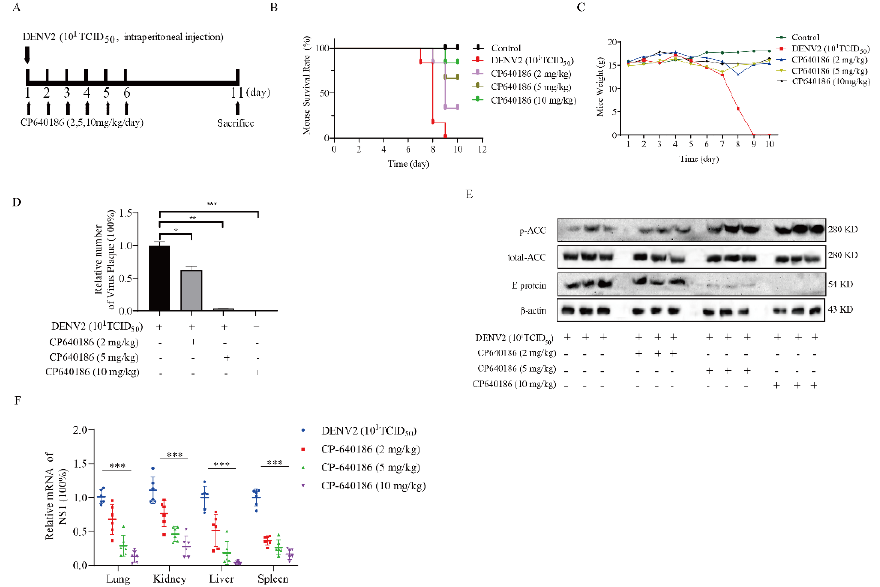
Figure 5. The antiviral effect of CP640186 in vivo. ( A ) Schematic diagram of mice infection assay. IFNAR − / − mice were infected with DNEV2 (10 1 TCID 50 ) at day 1. At the same time, the CP640186 (2 mg/kg/day, 5 mg/kg/day, and 10 mg/kg/day) was administered orally for 6 consecutive days. At day 11, these mice were sacrificed for histological analysis. ( B ) The mice survival rate curve. ( C ) The mice weight curve. ( D ) The inoculum of the virus (number) analysis in mouse serum was analyzed by the plaque focus forming assay. ( E ) The p-ACC and viral E protein levels were analyzed by Western blotting in liver tissue. ( F ) The mRNA level of NS1 in the various mice tissues. * indicates p < 0.1. ** indicates p < 0.01. *** indicates p <